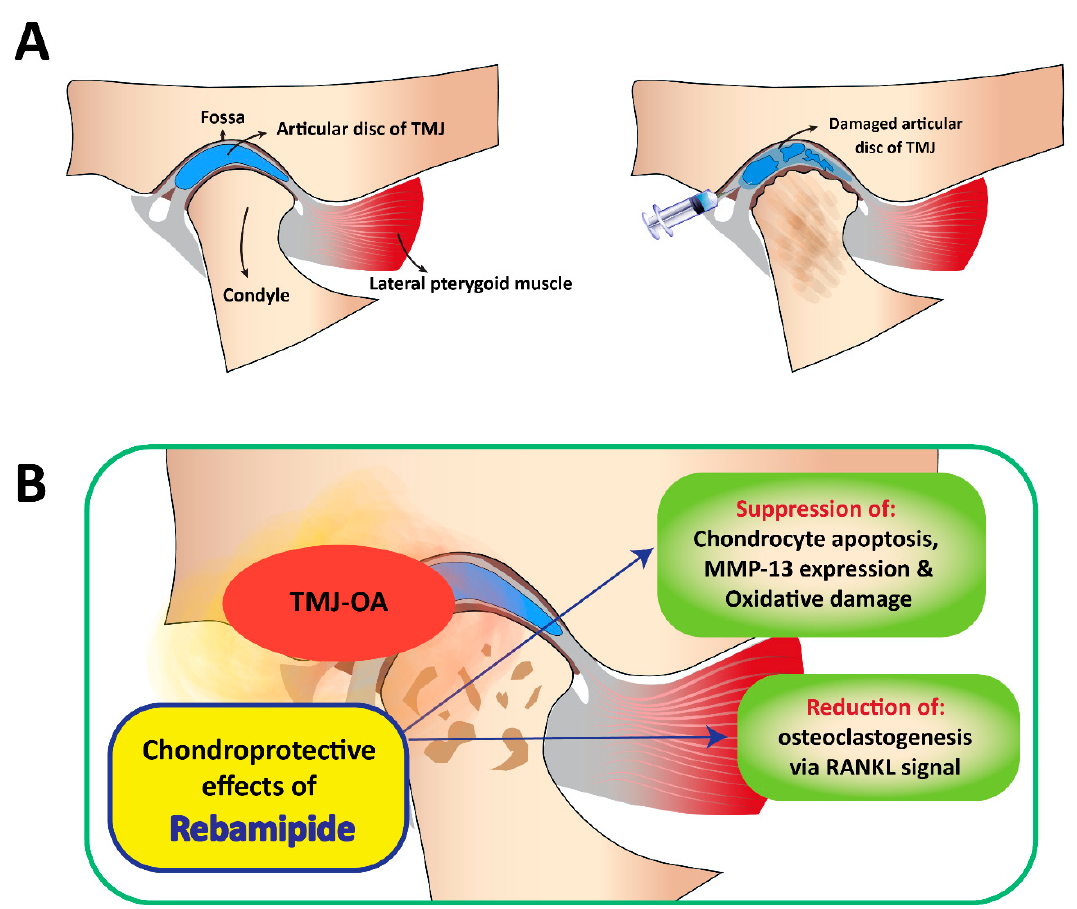
Figure 7. ( A ) A schematic showing TMJ anatomy and the commonly targeted areas to address